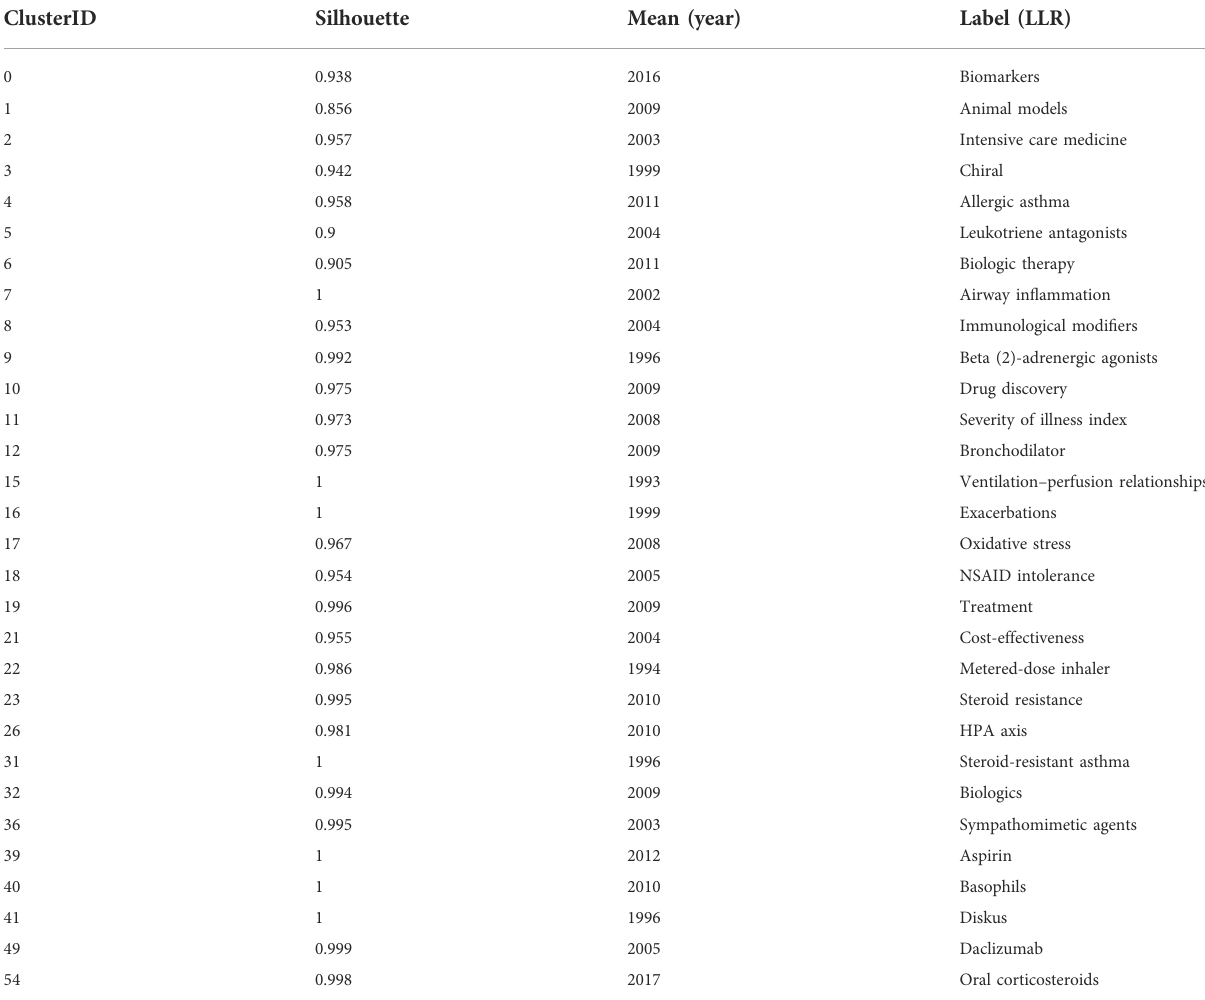
TABLE 10 Co-occurrence map of severe asthma drug-related study co-cited references cluster